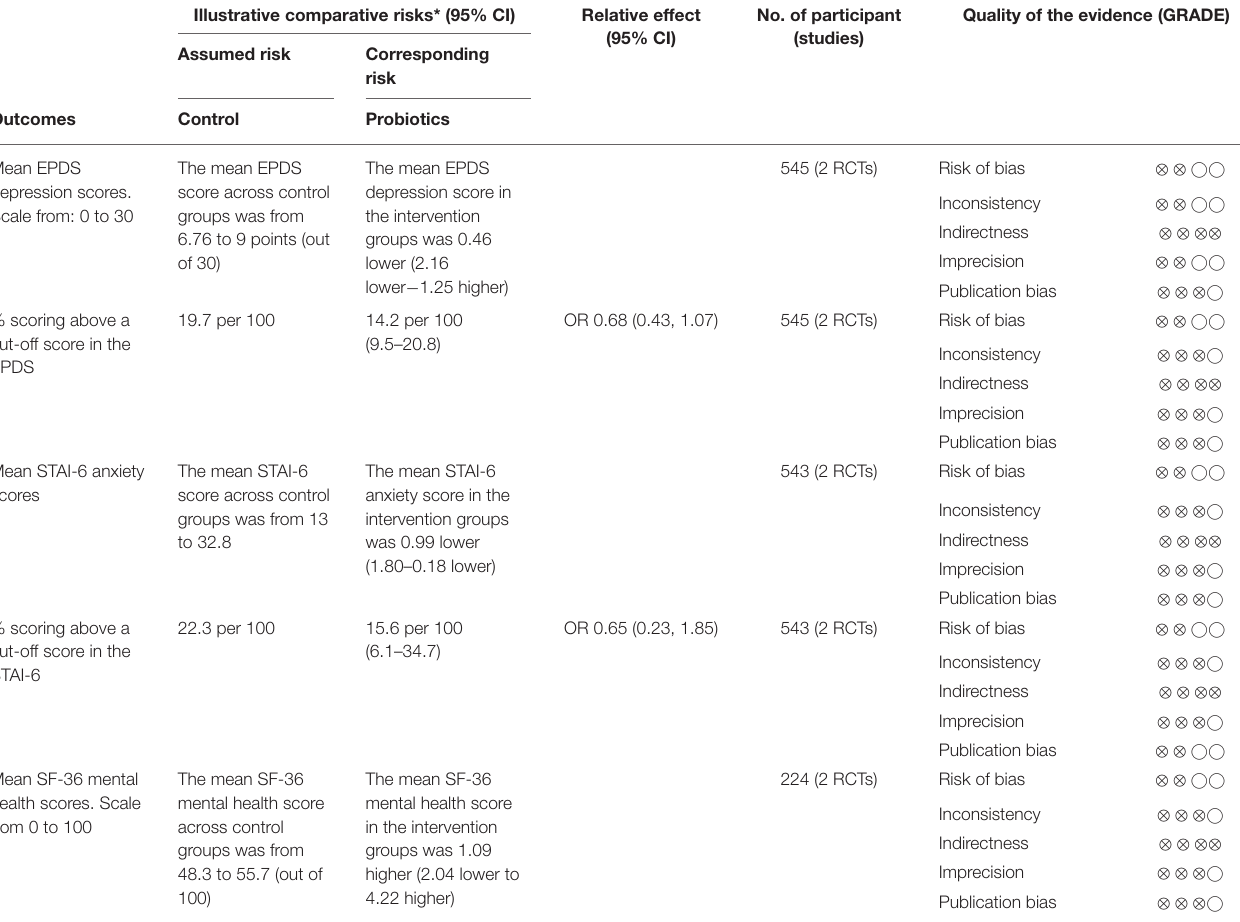
TABLE 2 | Summary of findings and quality of the evidence for the outcomes in the review. Illustrative comparative risks* (95% CI) Relative effect No. of participant Quality of the evidence (GRADE) (95% CI) (studies) Assumed risk Corresponding risk Outcomes Control Probiotics Mean EPDS depression